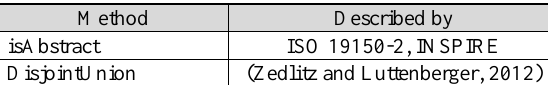
Table 1. Methods for transforming abstract classes